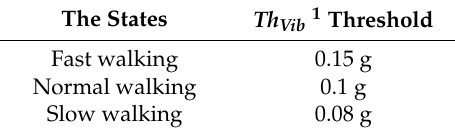
Table 4. The vibration elimination threshold for fast walking, normal walking, and slow walking states. The